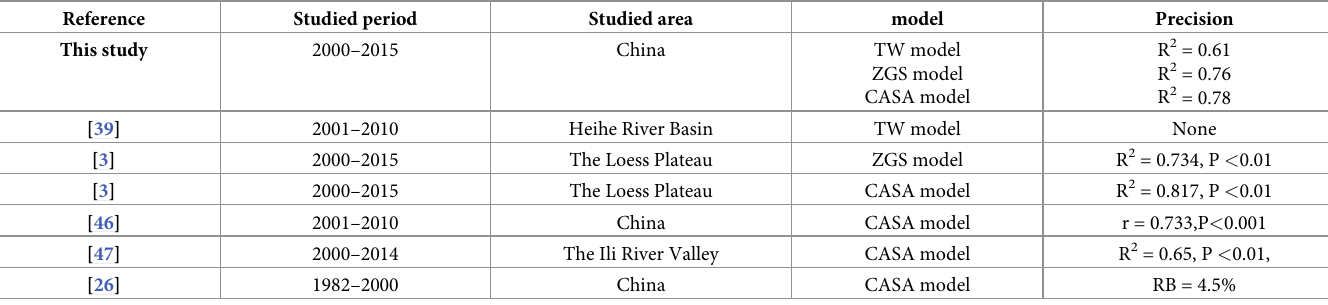
Table 1. Comparison of annual average NPP between this study and other studies.